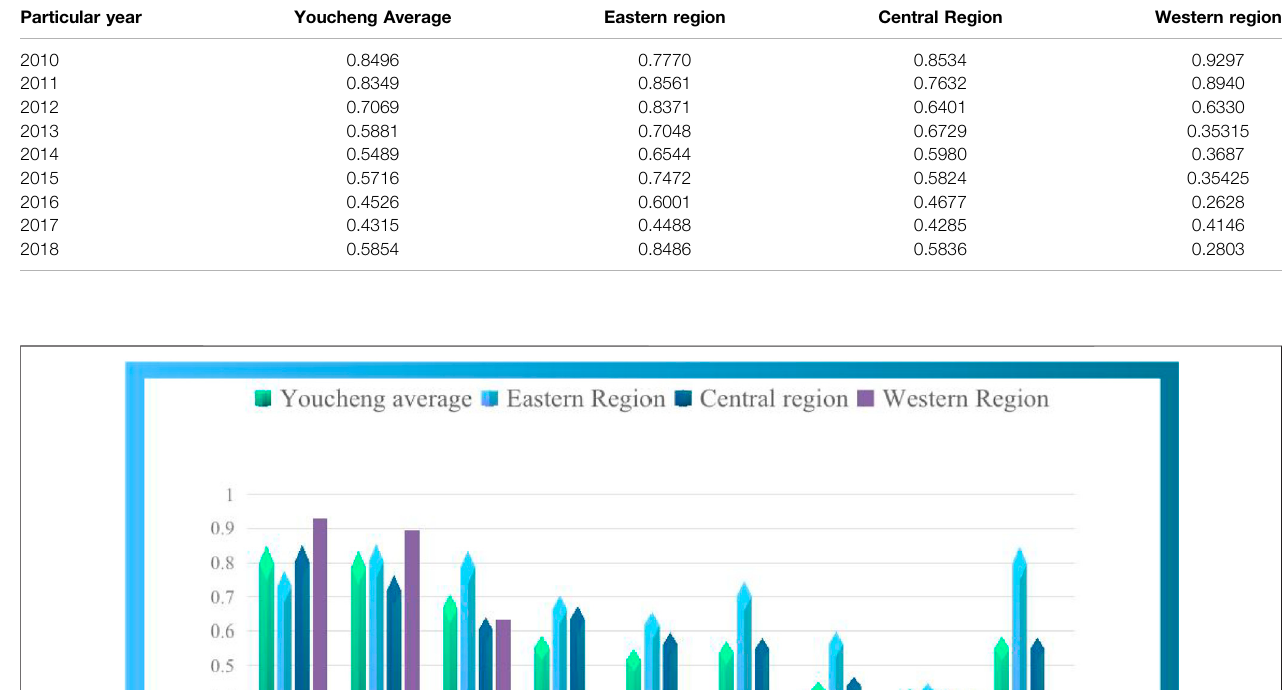
Frontiers in Earth Science |